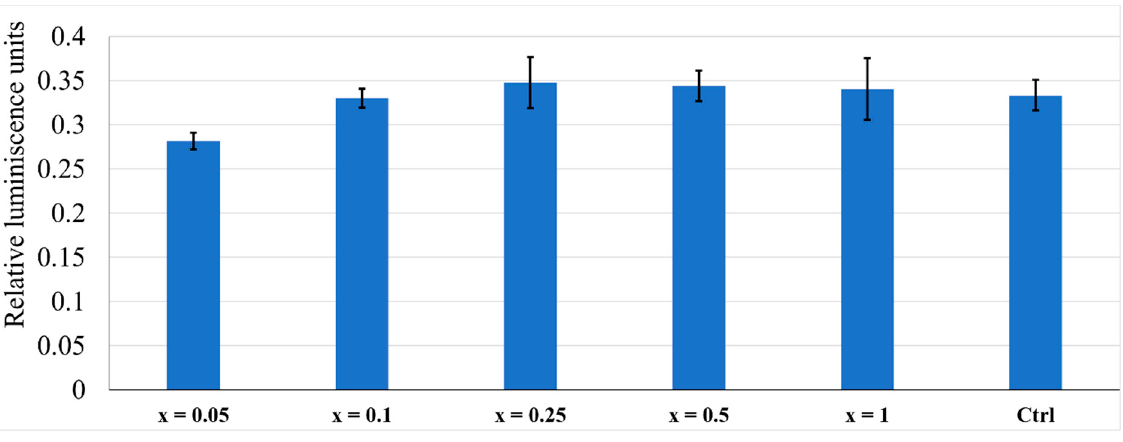
Figure 10. The AFSC of the terbium-doped HAp nanomaterials and control samples by GSH assay. Fluorescence microscopy images in Figure 11 show the viability of AFSC cells; Ca 10 − x Tb x (PO 4 ) 6 (OH) 2 nanomaterial samples have no cytotoxic effect, confirming the bio- chemical results. No dead cells or cell fragments are detected; AFSCs have a normal mor- phology, with a distinctive appearance.